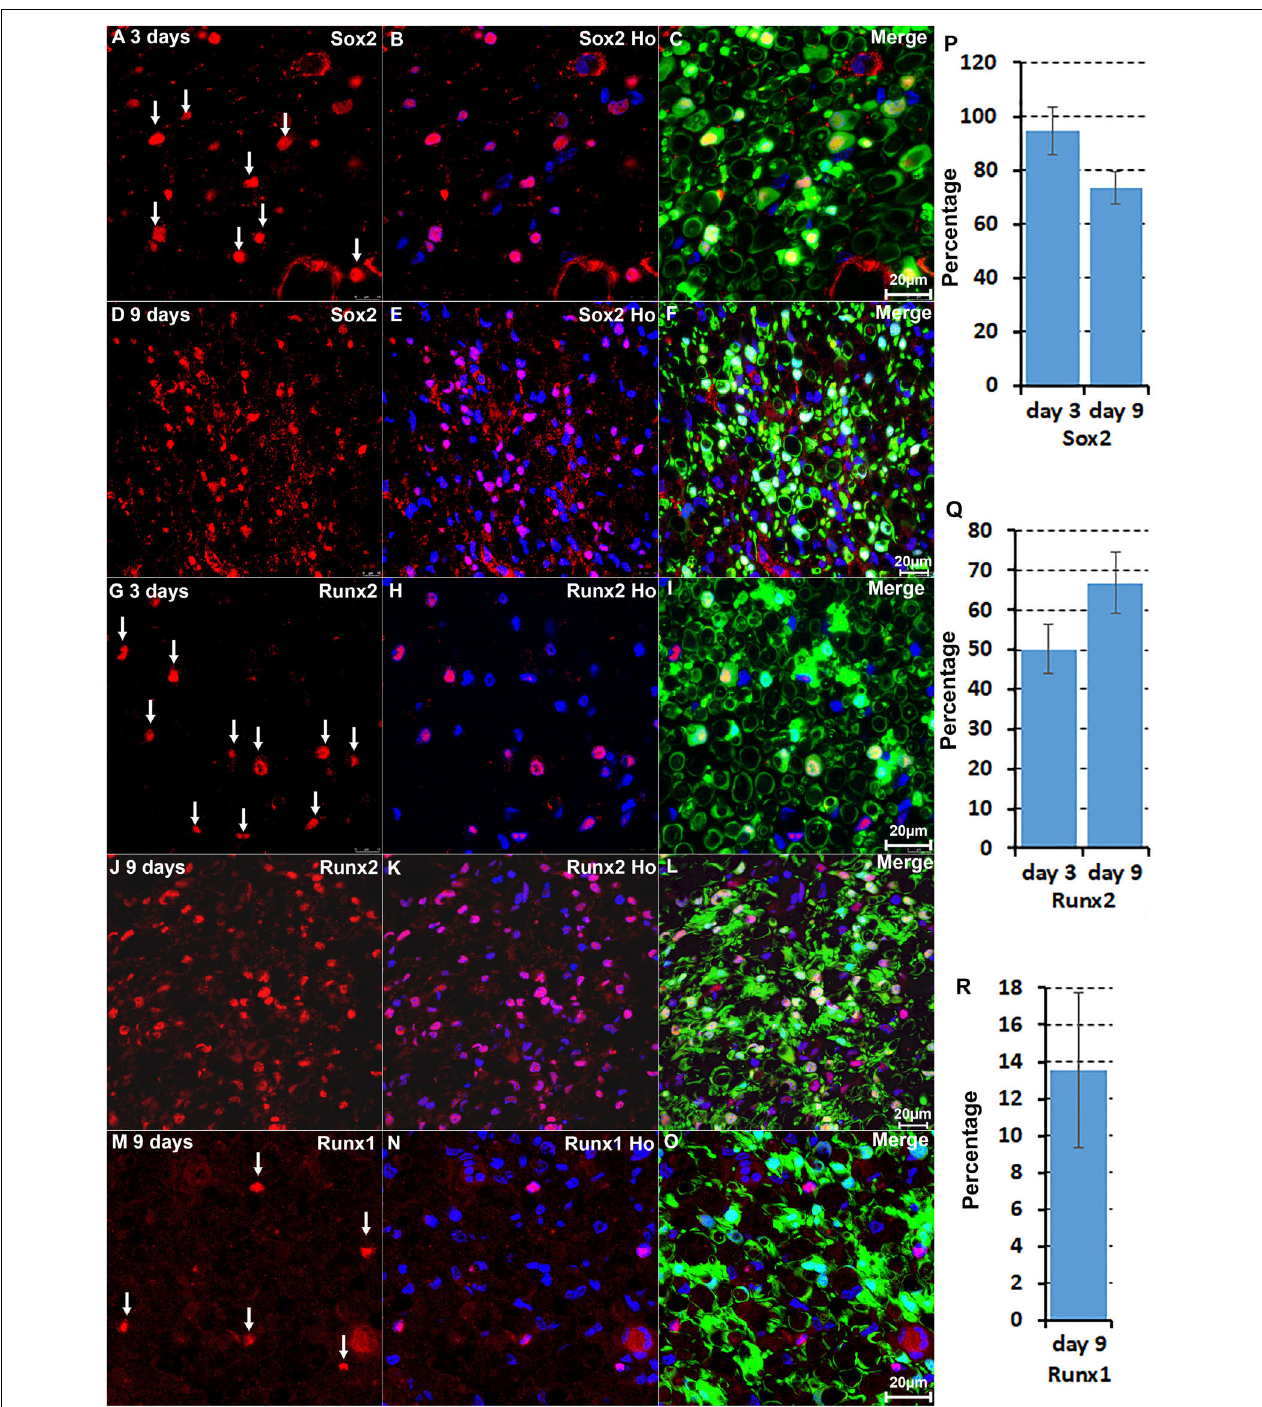
FIGURE 4 | Immunostaining validates Sox2 and Runx2 expression in Schwann cells. (A–C) Sox2 expression in Schwann cells at day 3 post-injury. (D–F) Sox2 expression in Schwann cells at day 9 post-injury. (G–I) Runx2 expression in Schwann cells at day 3 post-injury. (J–L) Runx2 expression in Schwann cells at day 9 post-injury. (M–O) Runx1 expression in non-Schwann cells (GFP negative) at day 9 post-injury. (P,Q) Quantification of Runx2 and Sox2 expressing Schwann cells against the total number of Schwann cells in the distal nerve stump. (R) Quantification of Runx1 expressing cells against the total number of GFP negative cells in the distal nerve stump. For all panels, sections of distal nerve following injury were prepared from PLP-GFP transgenic mice that label Schwann cells with GFP. Scale bars in C, F, I, L, and O: 20 µ m. Quantification data in (P–R) was shown as Mean ± SEM, n = 3.